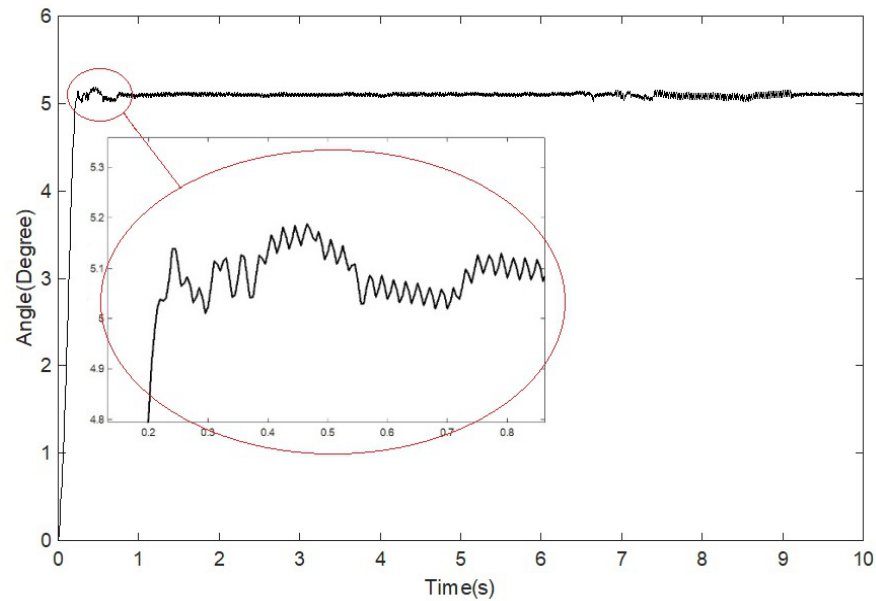
Figure 7. Chattering problem in experiment results.